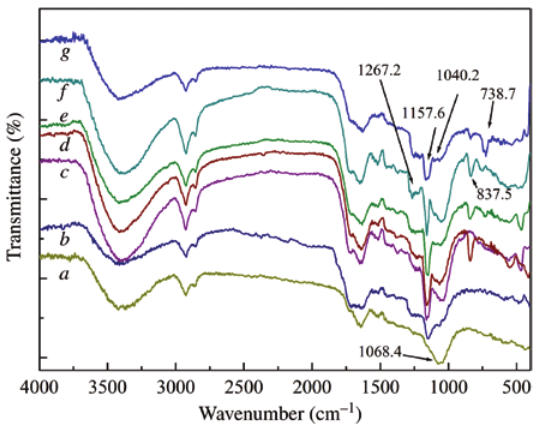
Figure 4: The FT-IR spectra of native SVR (curve a ), and the sulfates formed with sulfuric acid (curve b ), sodium sulfite (curve c ), sulfamic acid (curve d ), benzenesulfonic acid (curve e ), p -toluenesulfonic acid (curve f ) and sodium laurylsulfate (curve g ),